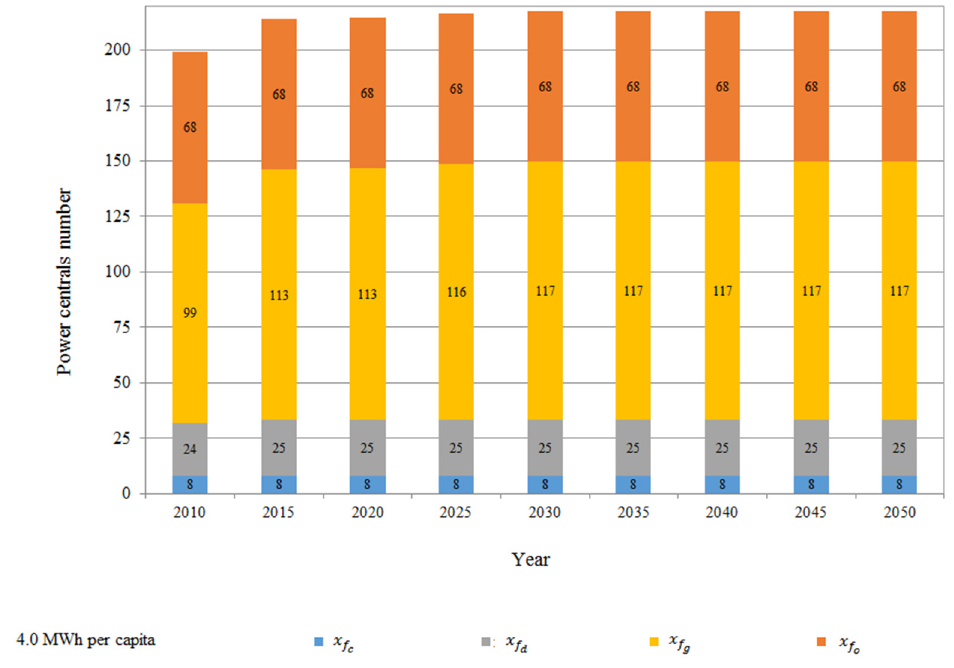
Figure 12. Optimized power plants number from fossil energy resource for 4.0 MWh per capita demand with the LVF model.